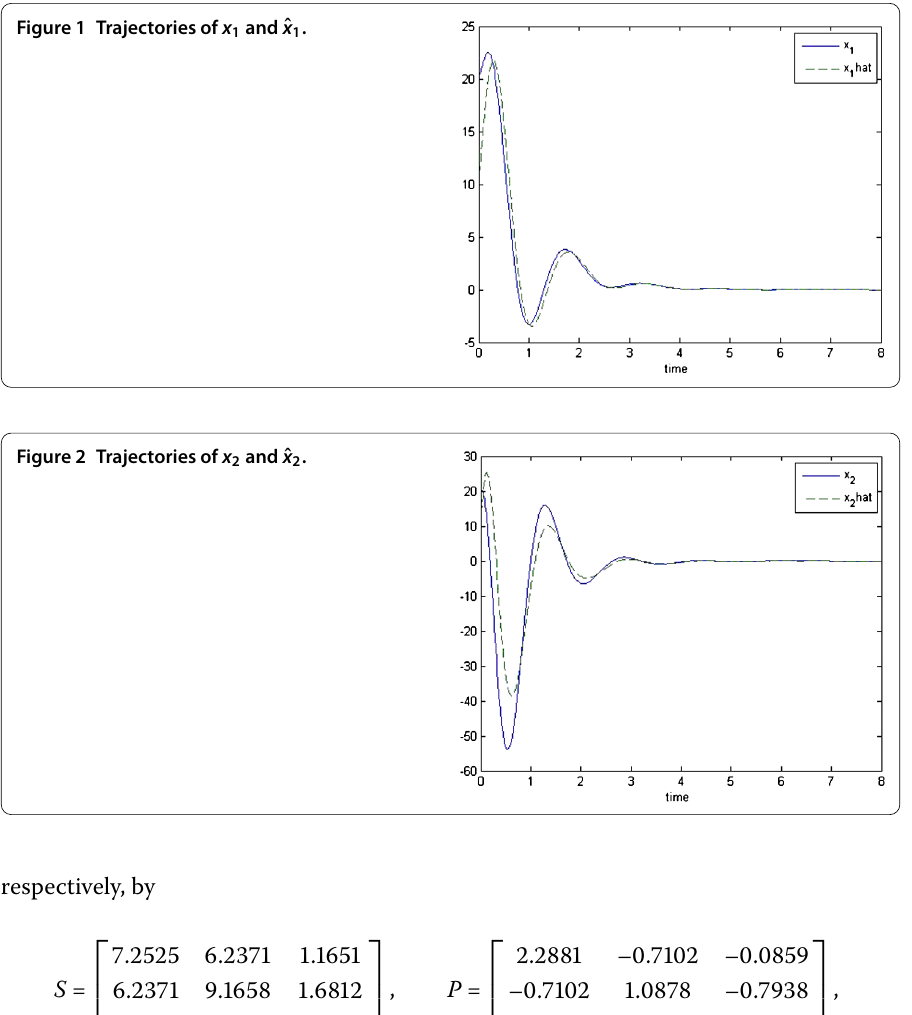
Figure 1 Trajectories of x 1 and ˆ x 1 .